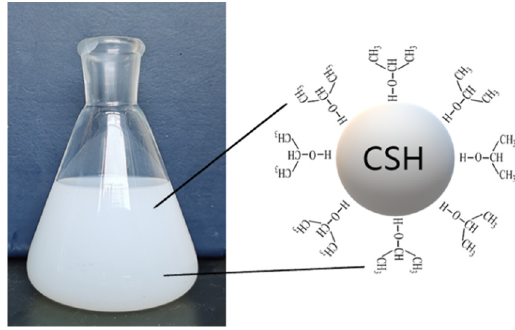
Figure 2. The CSH suspension in 2-propanol.